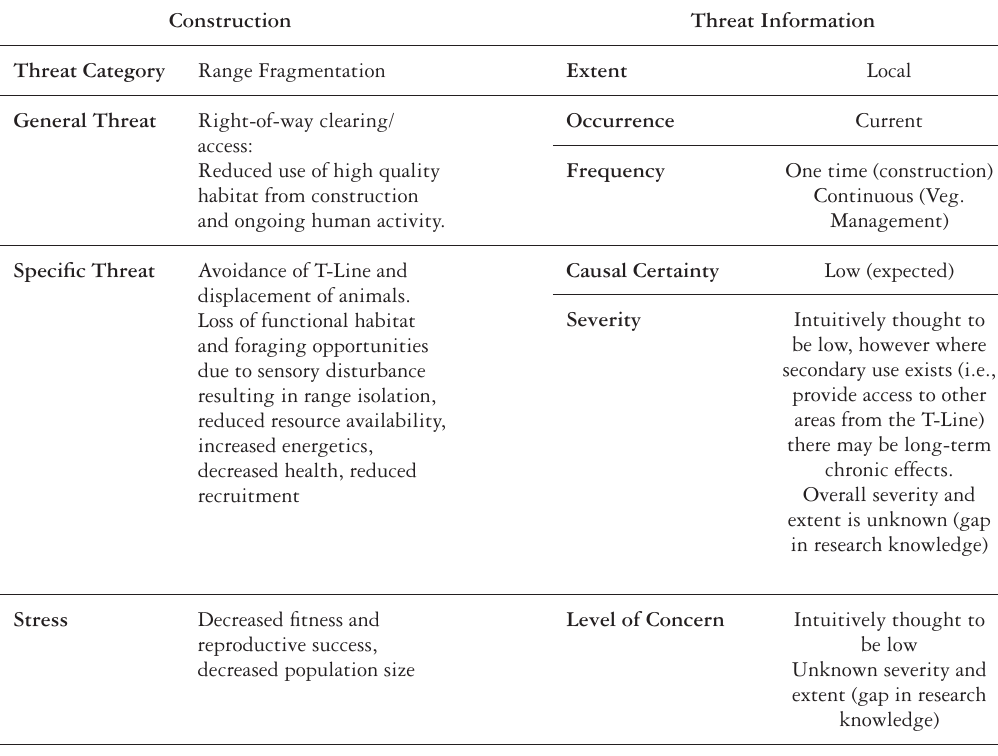
Table 2. Implications of threat categories for Site Selection and Environmental Assessment determined during Manitoba Hydro Boreal Woodland Caribou Workshop addressing boreal woodland caribou reduced use of habitat (less forage availability) away from right-of-ways due to sensory disturbance (human and ecological